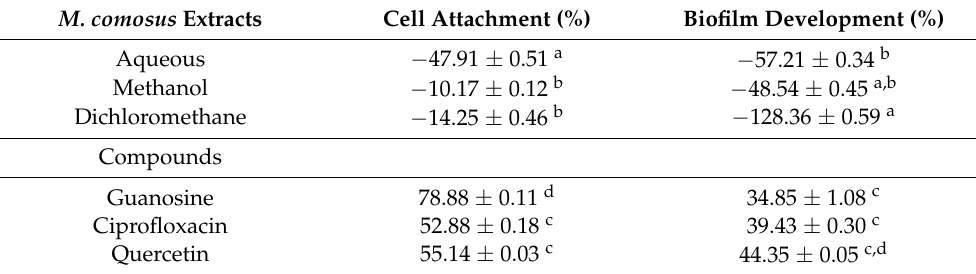
Table 4. Percentage inhibition of cell attachment and biofilm development by P. aeruginosa , following exposure to aqueous, methanolic and dichloromethane extracts of M. comosus